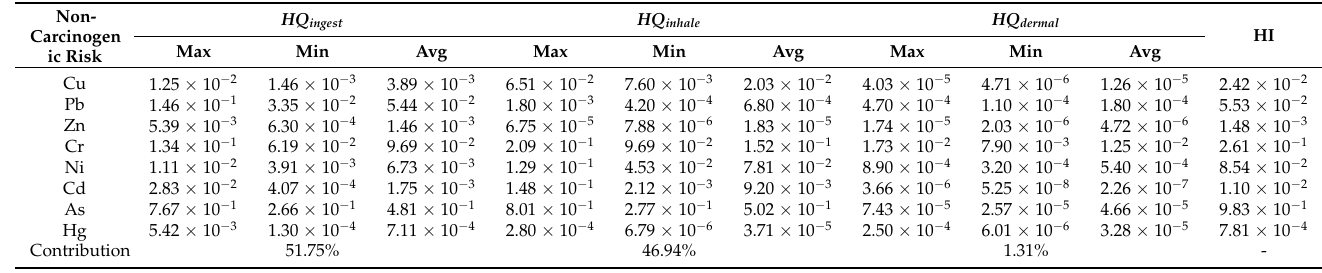
Table 3. Non-carcinogenic risk of heavy metals in topsoil around the landfill site.